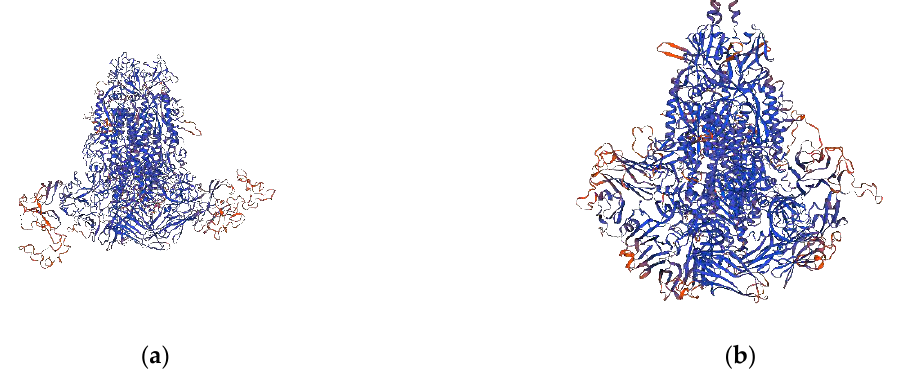
Figure 2. 3D structure prediction of PEDV S protein. ( a ) modelling the 3D structure of the S protein of CV777; ( b ) modelling the 3D structure of the S protein of